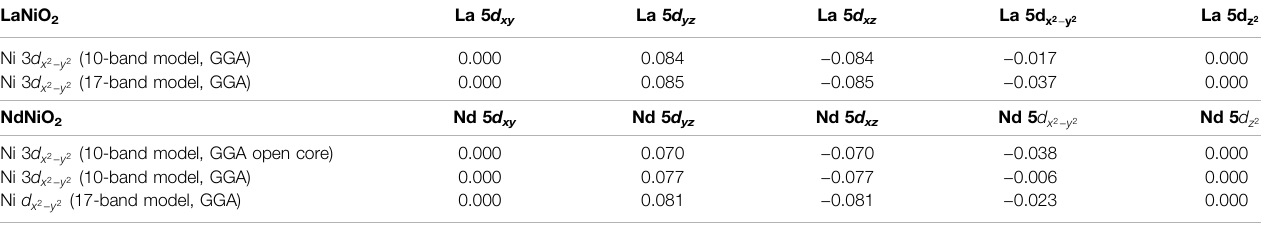
TABLE 1 | Hybridization (hopping amplitude in eV) between the partially occupied Ni 3 d x 2 − y 2 and the La/Nd 5 d orbitals [33]. Here, the results are obtained from Wannier projections onto 17-bands (La/Nd-4 f + La/Nd-5 d + Ni-3 d ) and 10-bands (La/Nd-5 d + Ni-3 d ). LaNiO 2